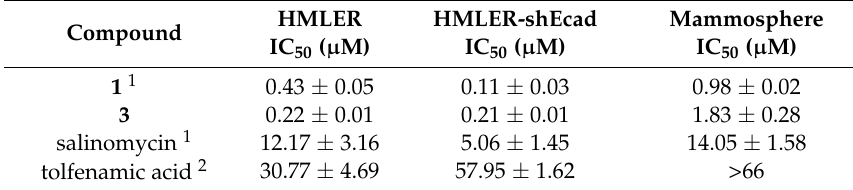
Table 1. IC 50 values of 1 , 3 , tolfenamic acid, and salinomycin against HMLER and HMLER-shEcad cells and HMLER-shEcad mammospheres determined after 72 or 120 h incubation (mean of three independent experiments ± SD). The IC 50 values correspond to the concentration required to decrease cell or mammosphere viability by 50% and were calculated from dose–response